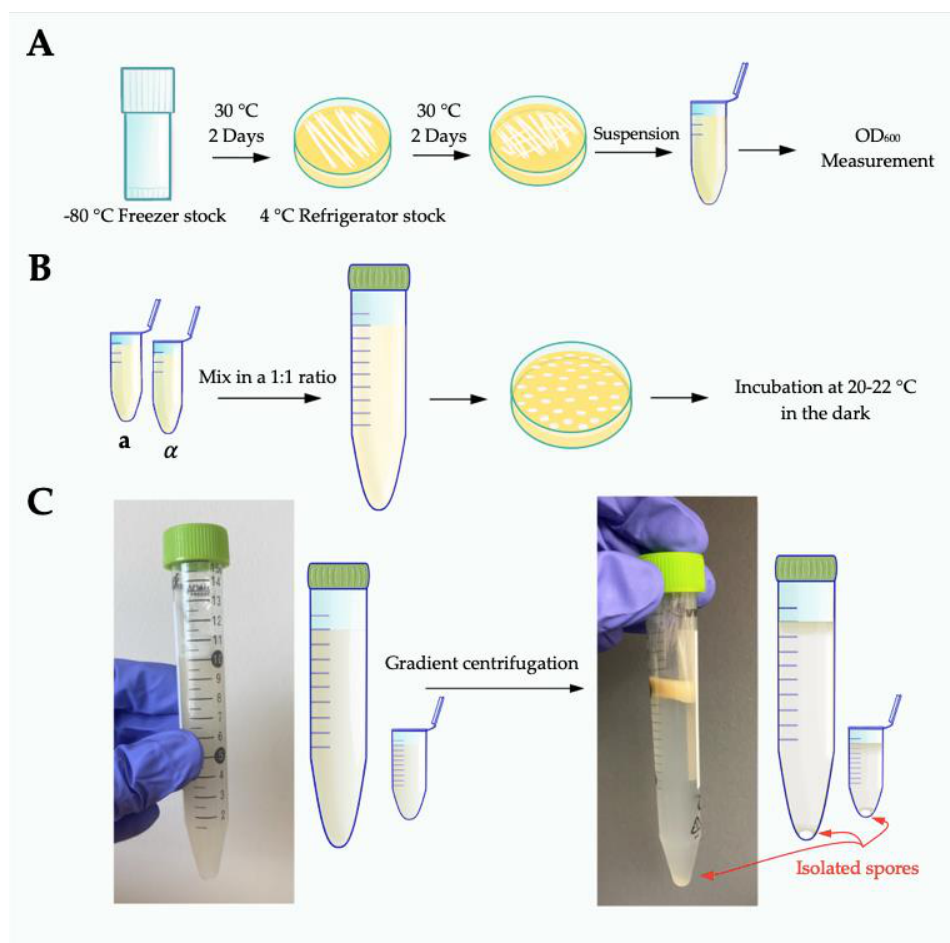
Figure 1. Illustrations of spore purification using JEC20 x JEC21 crosses. ( A ) Recover strains from the − 80 ◦ C freezer and plate on YPD agar. Grow for 2 days at 30 ◦ C. Transfer sufficient cells and streak to a new YPD plate, and grow for 2 days at 30 ◦ C. Suspend cells in 1 mL PBS for OD 600 measurement. ( B ) Mix strains in a 1:1 ratio in 10 mL PBS to a final total OD 600 equal to 2.0. Plate cells to V8 plates in 10 µ L spots using a multichannel pipette. Incubate at 20–22 ◦ C in the dark with the agar side down for 5–7 days. ( C ) Scrape the total mass of crosses and resuspend in 75% Percoll ® . Mix thoroughly to homogeneity by vigorous vortexing (left panel). Centrifuge at 4 ◦ C at 4000 RPM/21,410 × g in a swinging bucket rotor for 25 min to generate a density gradient. Spores will sediment to the bottom of the tubes, all other cell types will be at the top of the gradient. In a suc- cessful purification gradient, there will be a clearly visible separation between spores and all other cell types (right panel).